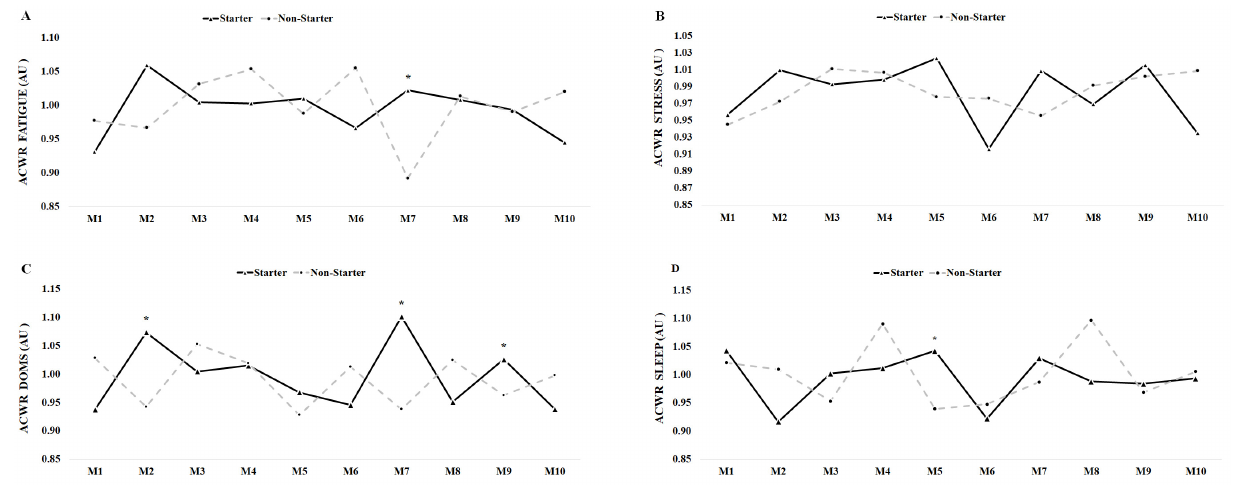
Fig. 2. Acute: Chronic Workload Ratio (ACWR) variations calculated through the HI categories across 10 mesocycles (M1-10) for starters and non-starters. (A) Fatigue. (B) Stress. (C) DOMS. (D) Sleep. * denote significant difference from non-starters ( p < 0.05); # denote significant difference from M10 ( p <